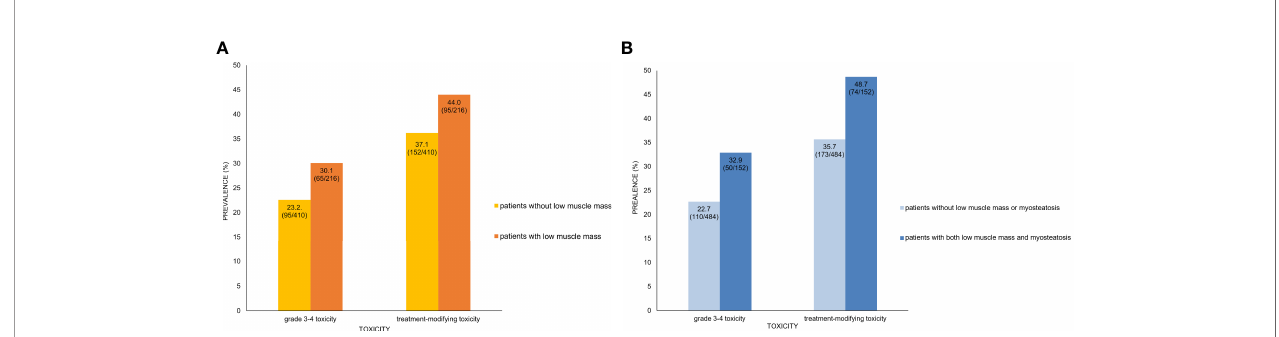
FIGURE 2 | Prevalence of toxicity and presence of low muscle mass only (A) and both low muscle mass and myosteatosis (B) . (A) In patients with low muscle mass, 30.1% and 44.0% showed grade 3 – 4 toxicity and treatment-modifying toxicity, respectively. In contrast, patients without low muscle mass had lower prevalence of severe toxicity (23.2%) and DLT (37.1%). (B) Patients who had both low muscle mass and myosteatosis had higher prevalence of grade 3 – 4 toxicity (32.9% vs. 22.7%) and treatment-modifying (48.7% vs. 35.7%) than those without low muscle mass or myostatosis. Note that the inter-group difference of toxicity prevalence is larger between patients with and without both low muscle mass and myosteatosis than between those with and without low muscle mass